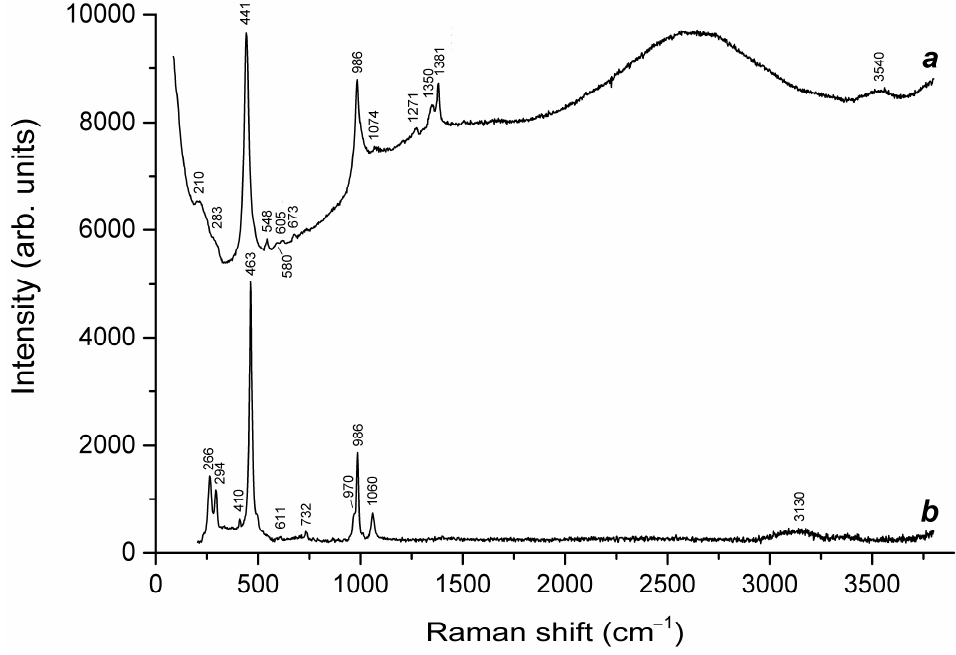
Figure 2. Raman spectra of ( a ) bolotinaite (Sample 10) and ( b ) sodalite (Sample 11).